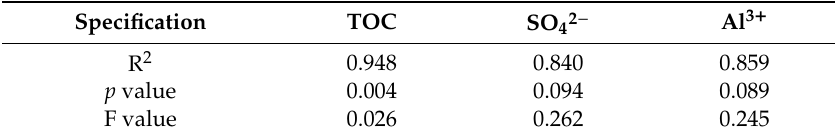
Table 2. Regression analysis.